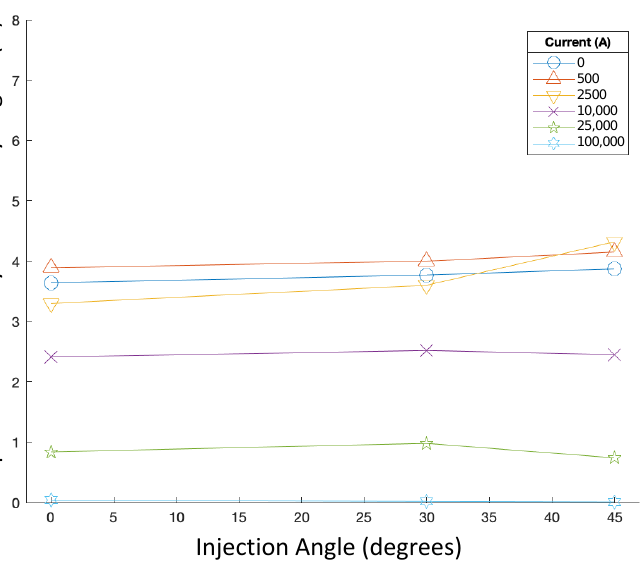
Figure 10. Deposition efficiencies in varying magnetic fields for different injection angles of tar- geted injections.